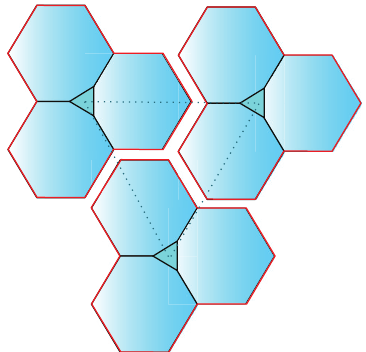
Figure 2: A CA consists of three adjacent sites.